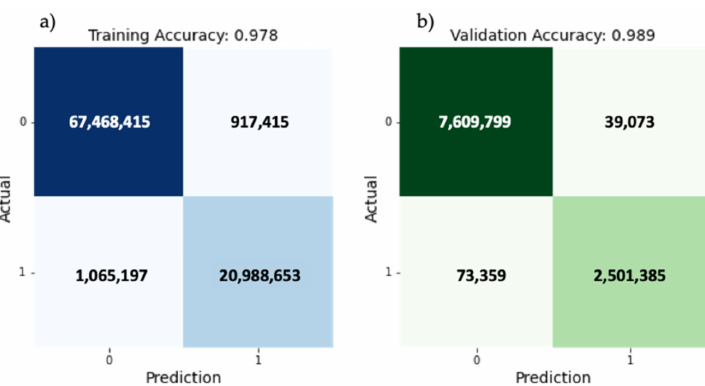
Figure 15. The confusion matrix of ( a ) training and ( b ) validation data.